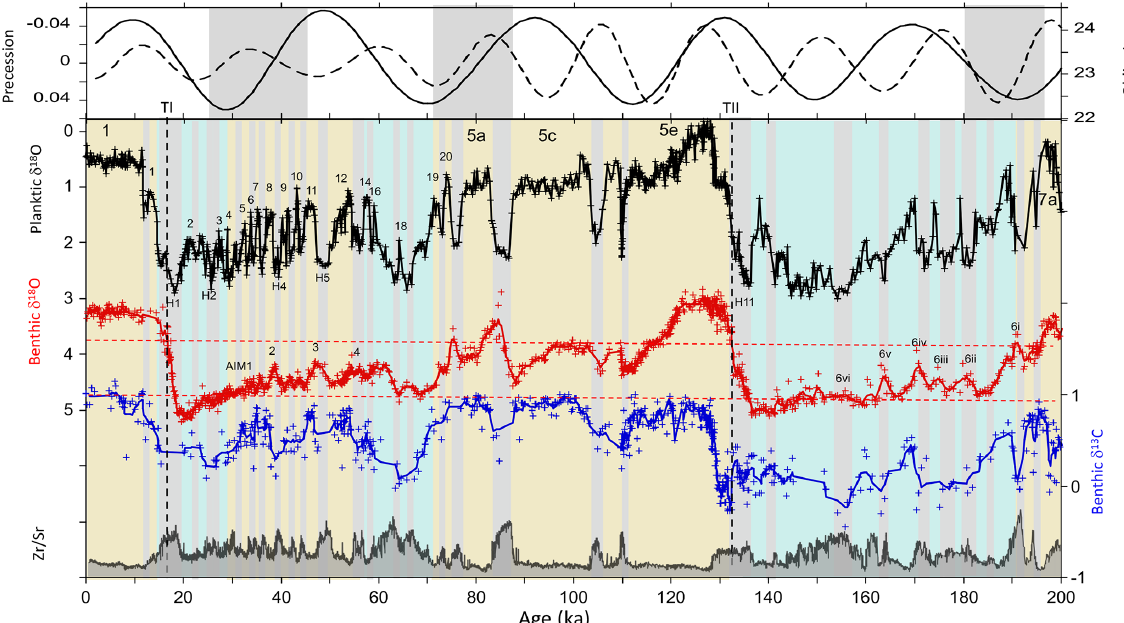
Figure 6. 0–200ka: Planktic δ 18 O of G. bulloides (black), benthic δ 18 O of Cibicidioides spp. (red), obliquity (solid line), precession (dashed line), benthic δ 13 C of C. wuellerstorfi (blue), and Zr–Sr (grey). Odd marine isotope stages (interglacials) are numbered and shaded yellow. Greenland interstadials are numbered, and prominent Heinrich stadials (H) are identified. Even-numbered glacial periods are shaded blue, with stadial events identified by grey vertical bars. Stadials during MIS 6 are numbered after Margari et al. (2010). Terminations are indicated by vertical dashed black lines, and roman numerals have been placed approximately near the mid-point of the deglaciation, although millen- nial events on the termination often make it difficult to exactly define this point. Horizontal dashed red lines correspond to the benthic δ 18 O thresholds marking the window of enhanced millennial variability. Precession and obliquity are plotted such that boreal summer insolation increases in the up direction. The grey shading indicates times when strong MCV is associated with declining or low obliquity, especially associated with glacial